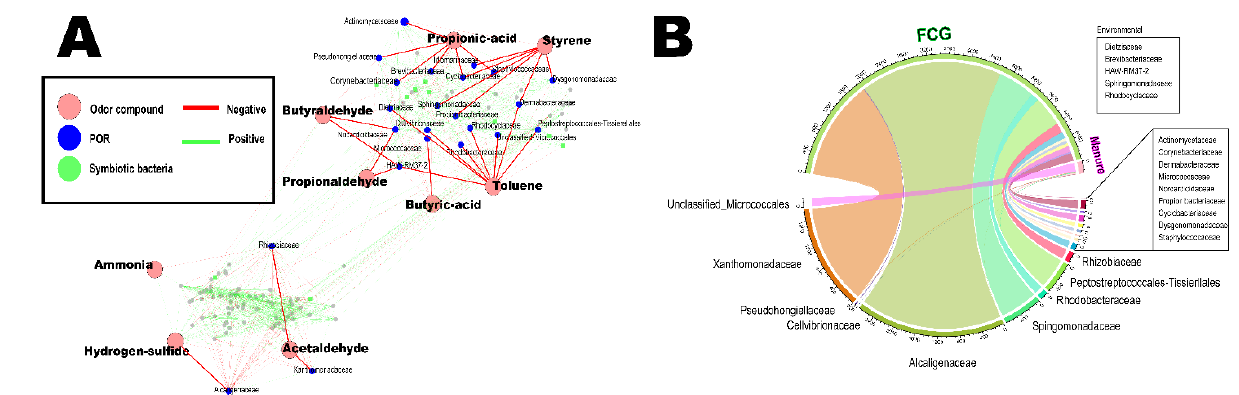
Figure 5. Network and potential odor reducer (POR) distribution. ( A ) The nodes of the network plot are differentiated by shape and color into the bacterial families, ecological roles, and contribution to odor reduction. Red and green edges imply negative and positive correlations, respectively. Significantly, the negative correlation between PORs and odor compounds is highlighted in solid red lines. ( B ) The plot indicates the sum abundance (normalized by rarefaction) of PORs in two initial sample groups: fermented coffee grounds and manure.